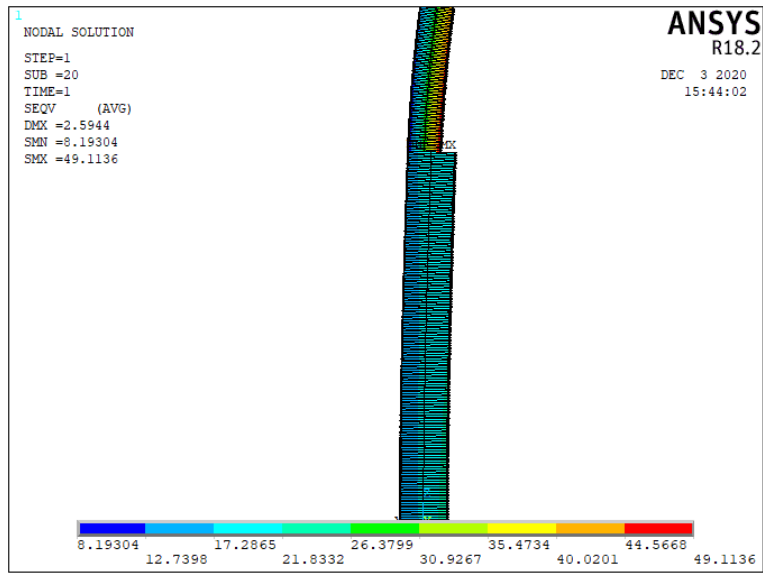
Figure 10. Mises stress diagram of the steel bent frame column. Figure 9. Total displacement diagram of the steel bent frame column. Figure 9. Total displacement diagram of the steel bent frame column.